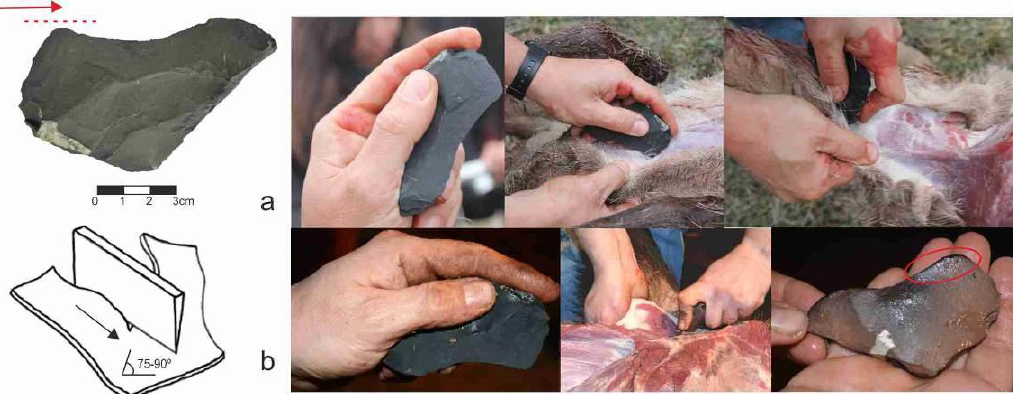
Figure 1. Ishbas1-MC1flake used for skinning: a) time 1 – deer skinning; b) time 2 – wild boar skinning. Dashed line on the edge indicates the most active area of edge used during the experiment. Arrow indicates direction of tool movement. The illustration below shows direction of movement and the working